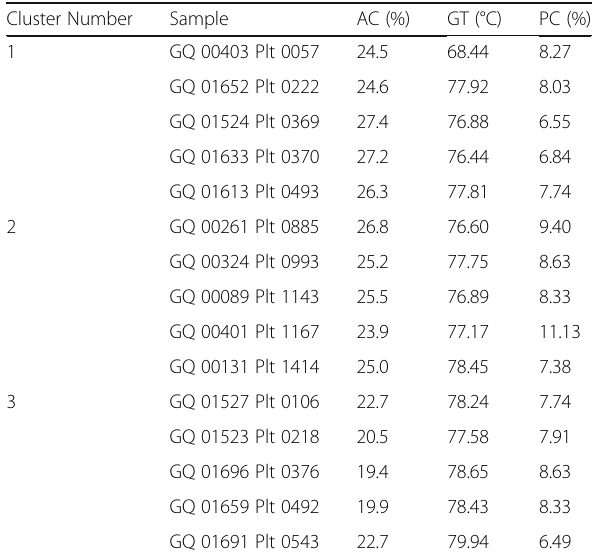
Table 6 Samples that underwent descriptive sensory profiling from the three clusters and their values for AC, GT, and PC. IDs linked to accession names have been described in